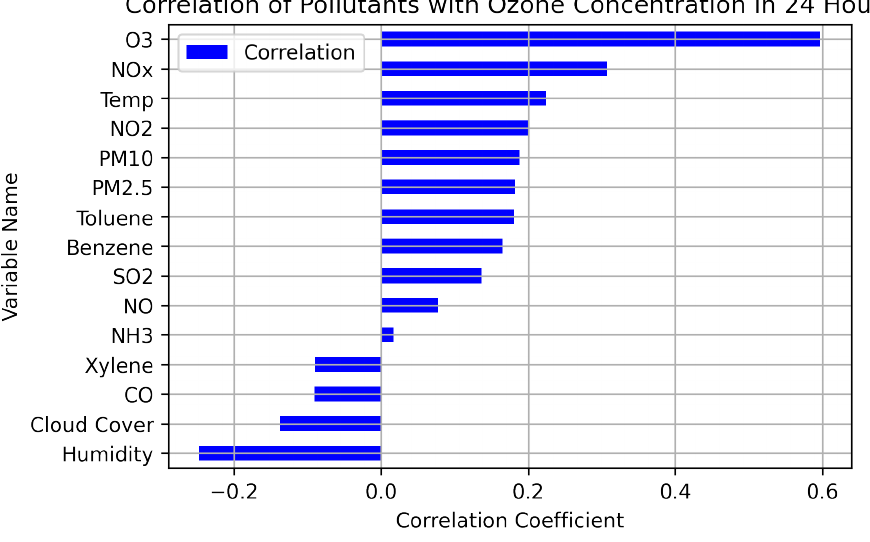
Figure 9. Correlations between variables and ozone 24 h later, ordered by correlation. The two chemical precursors of ozone, NO 2 and CO, have some of the highest correlations (positive and negative), along with the current ozone